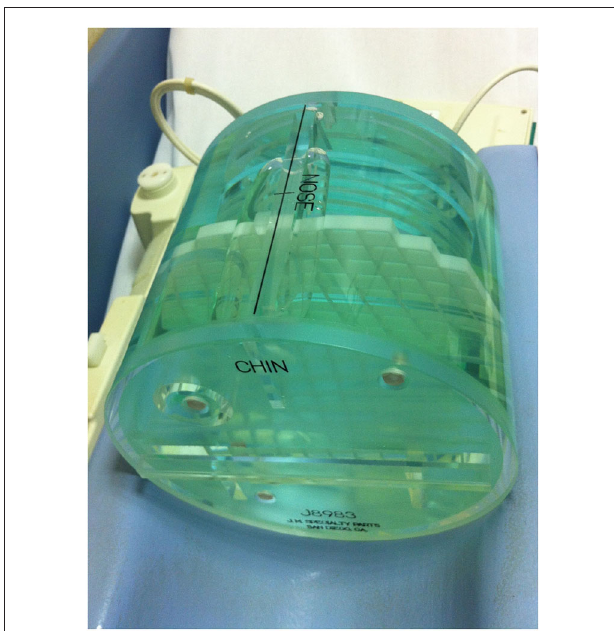
FIGURE 3 | A photograph of the ACR MRI Phantom in the head coil used to evaluate possible image artifacts due to the presence of the device.